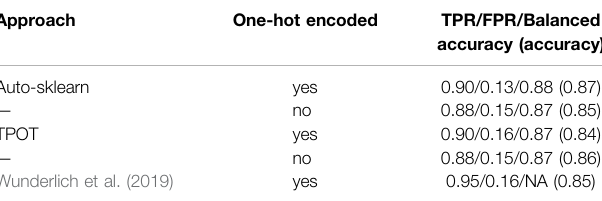
TABLE 3 | Results of the two AutoML experiments conducted by us and of the experiment of Wunderlich et al. (2019) using a conventional ML approach.